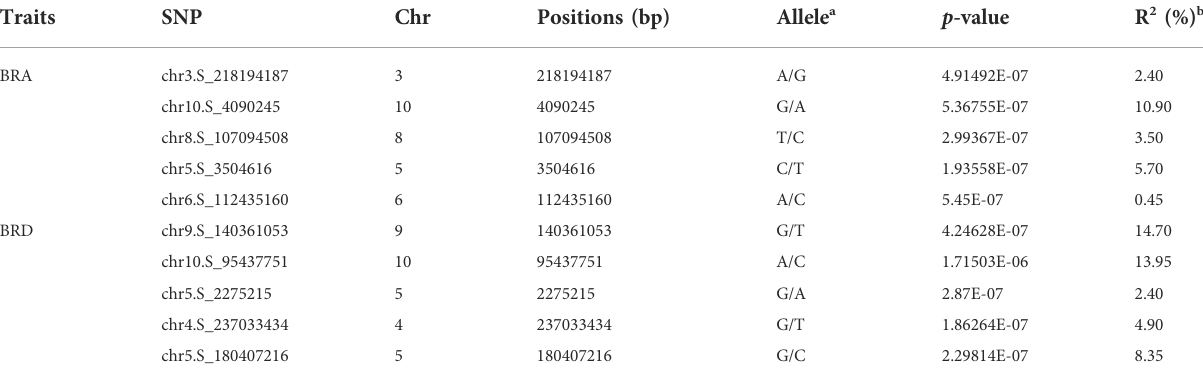
TABLE 2 Positions of SNPs signi fi cantly correlated with BRA and BRD were Co located by MLM and BLINK.